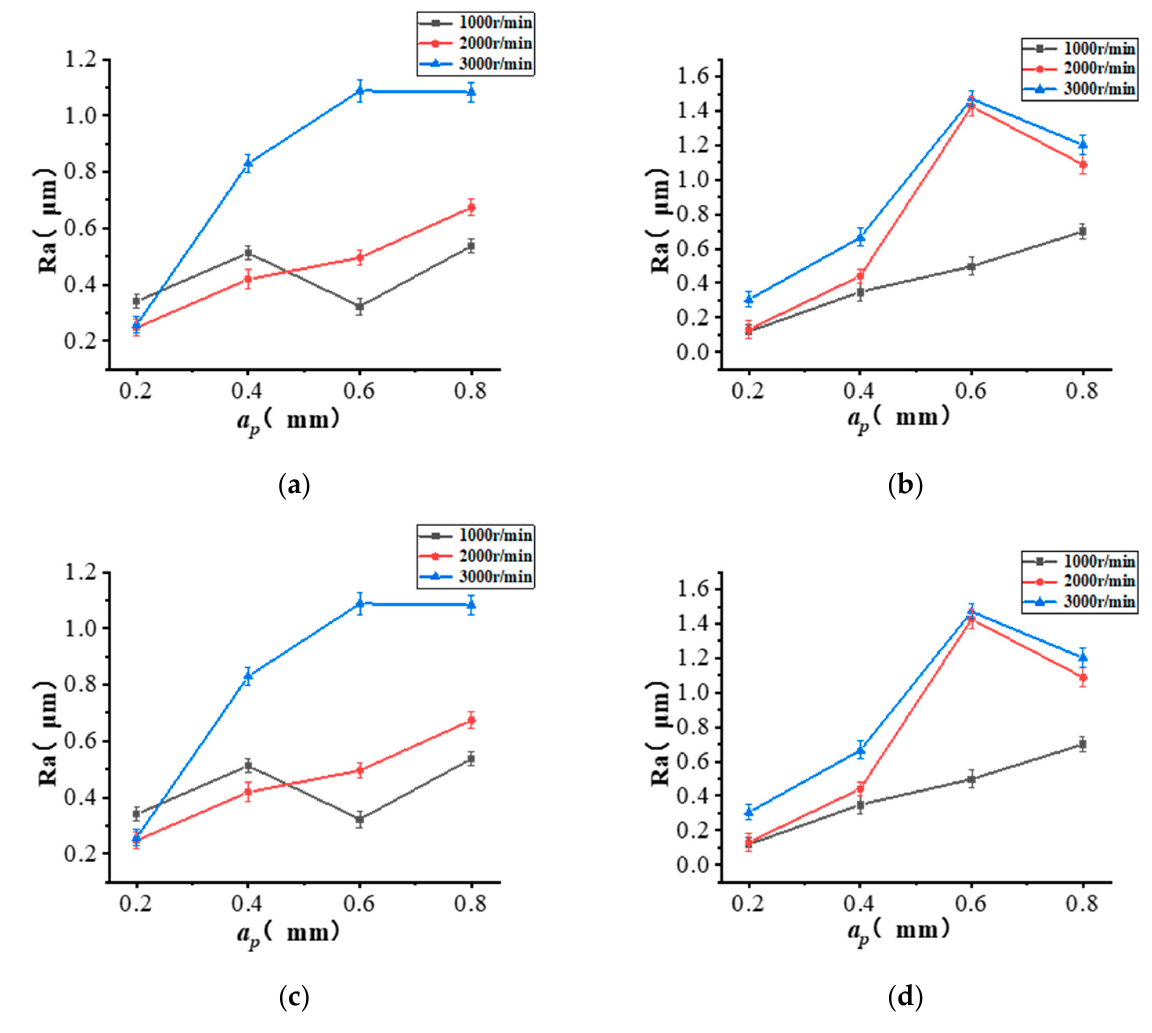
Figure 14. Surface roughness of helical milling hole with different processing parameters of TriMule. ( a ) Position 1; ( b ) Position 2; ( c ) Position 3; and ( d ) Position 4.